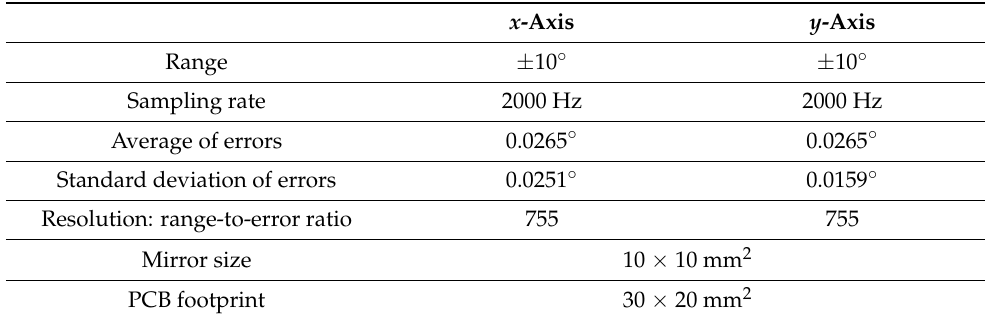
Figure 11. Experimental result: actual angles versus sensor outputs. Table 3. Performance of the proposed